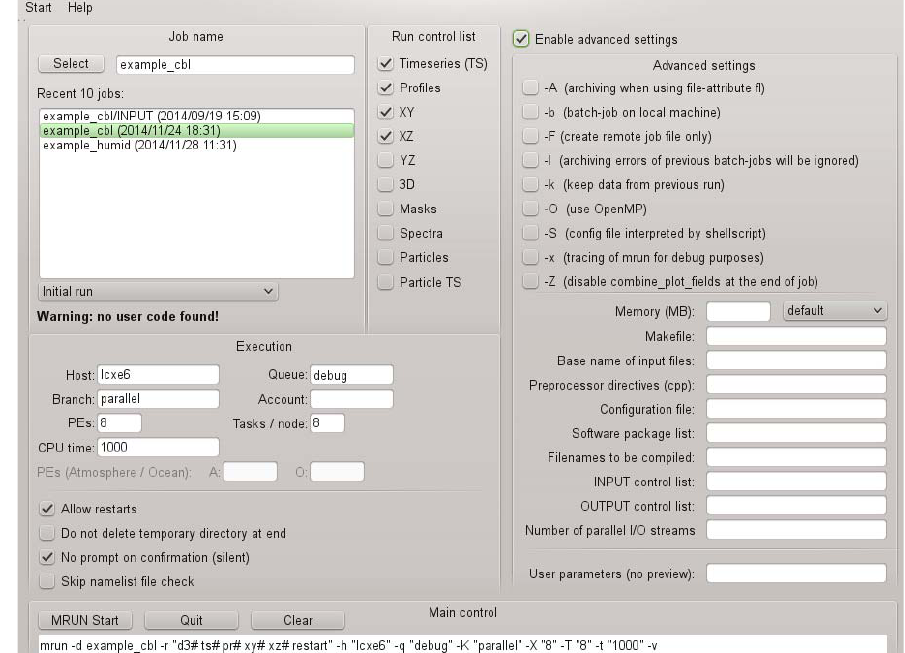
Figure 13. Screenshot of the mrunGUI program.